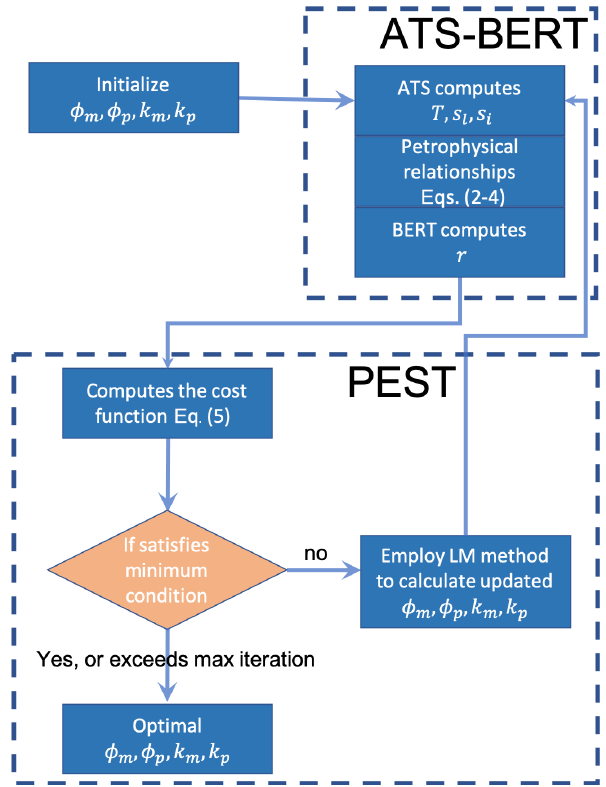
Figure 1. Schematics of the parameter estimation algorithm. The algorithm starts with initial guesses on porosities and thermal con- ductivities { φ,k } = { φ m ,φ p ,k m ,k p } for the peat and mineral layers. The coupled ATS–BERT forward model then simulates temperature ( T ), liquid water saturation ( s l ), ice saturation ( s i ), and apparent re- sistivities ( ρ a ), which are passed to the cost function. If the cost function is small enough, { φ,k } are considered to be the estimated parameters. If not, the values of the { φ,k } are updated according to the Levenberg–Marquardt (LM) minimization algorithm and passed back to the ATS–BERT